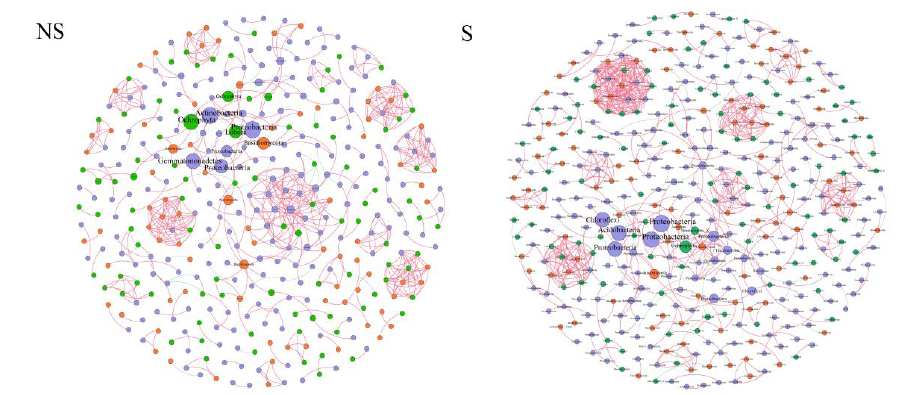
Figure 10. The network visualized the effects of light (shading (S) and no shading (NS)) on the co-occurrence patterns among soil protists, bacteria, and fungi at family level and comparison of topological features between two groups of co-occurrence networks. The edge indicates that there is a significant Spearman’s rank correlation (ρ > 0.9, p < 0.05). The node size represents the size of the BC value. Blue dots represent bacteria, red dots represent fungi, and green dots represent protists. The color of the edge indicates the type of correlation; positive correlations are filled with red and negative correlations are filled with green.